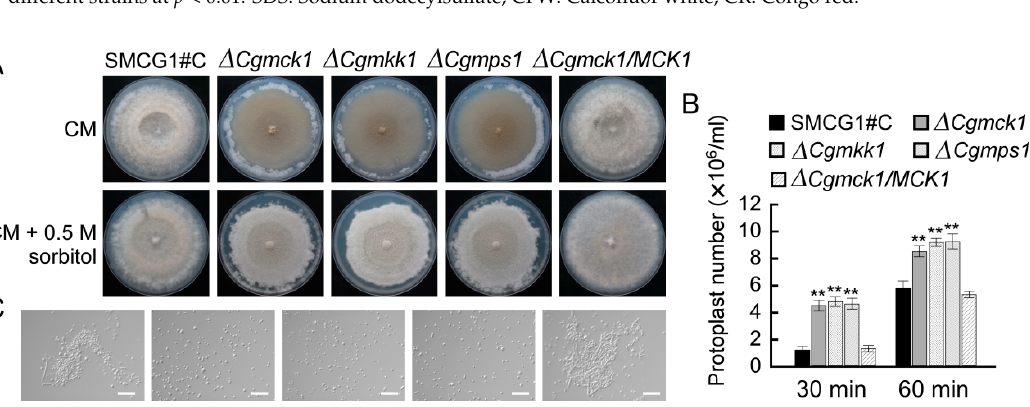
Table 1. Inhibition rate of mycelia growth of the targeted gene mutants exposed to the cell wall-perturbing agents and osmotic stresses (%).